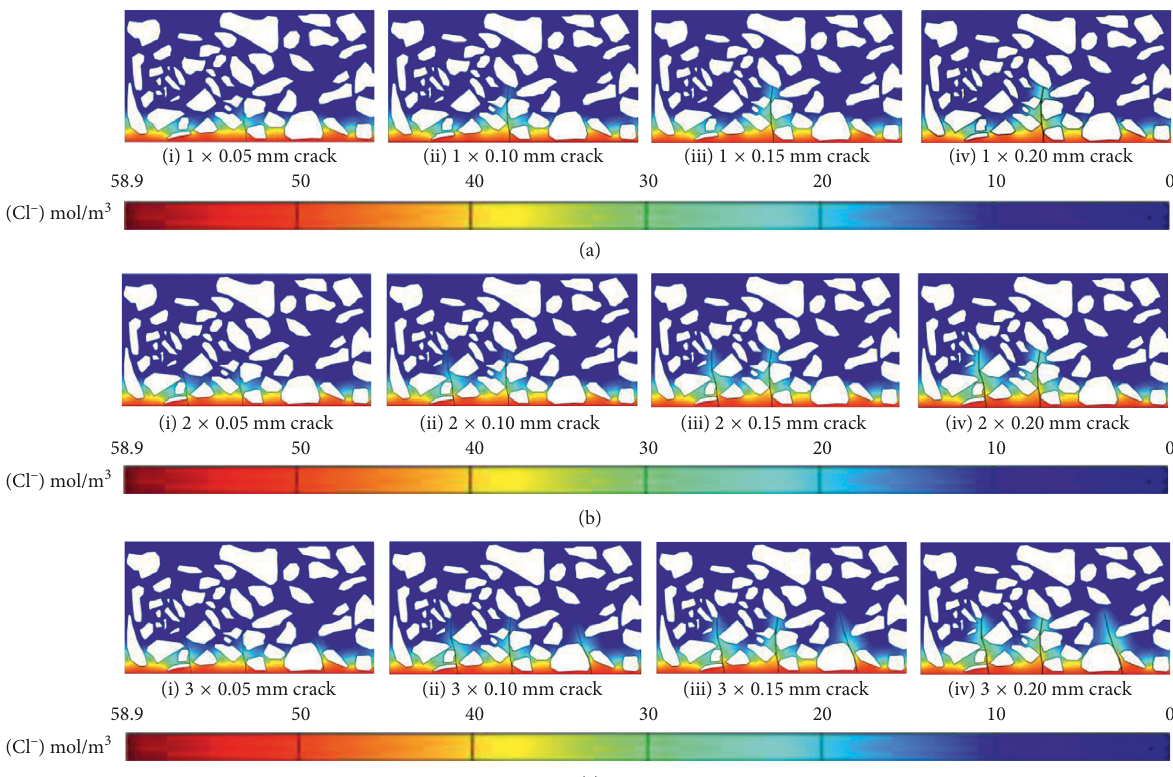
Figure 11: Concentration distribution profiles of chloride ions in concrete with (a) 1 crack, (b) 2 cracks, and (c) 3 cracks with different crack widths and crack quantities at 0.1